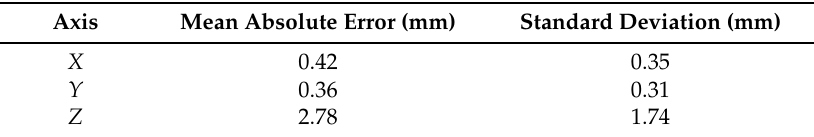
Table 1. Statistical analysis of errors between estimated and actual corners.